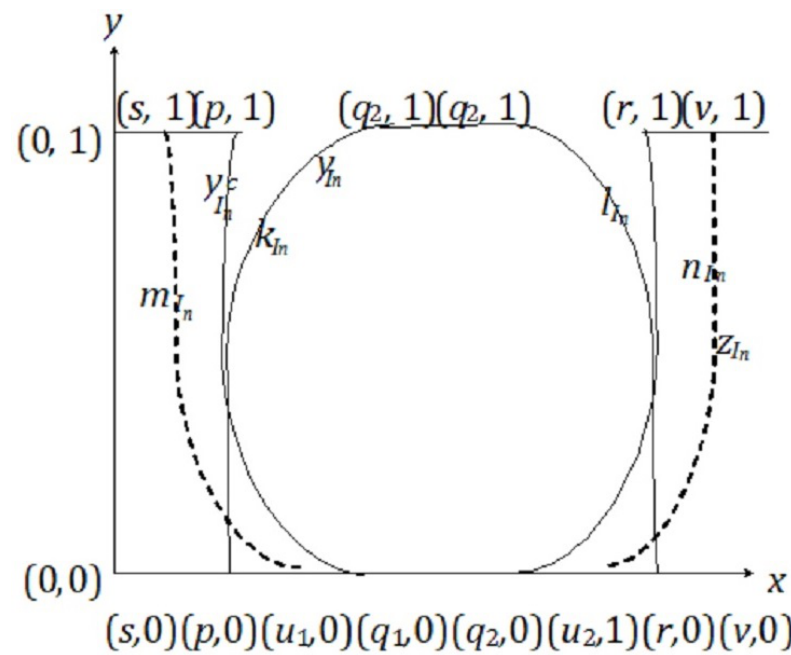
Figure 1. Intuitionistic fuzzy